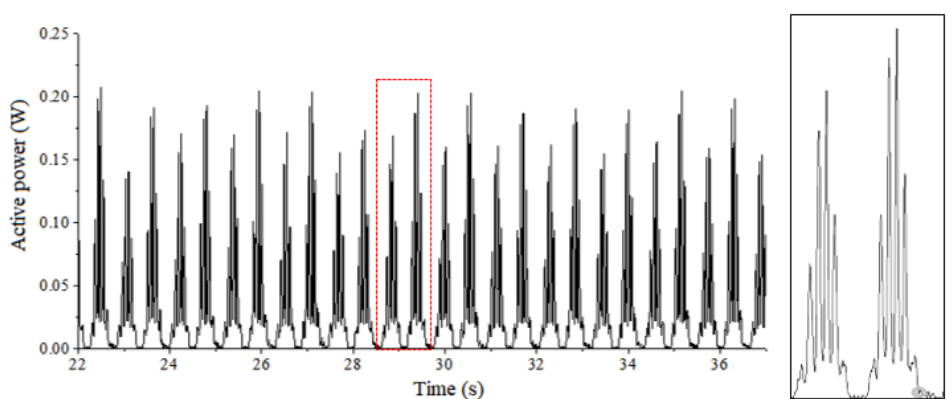
Figure 20. Active power diagram (including the zoom-up of the enclosed region between 28.0 s and